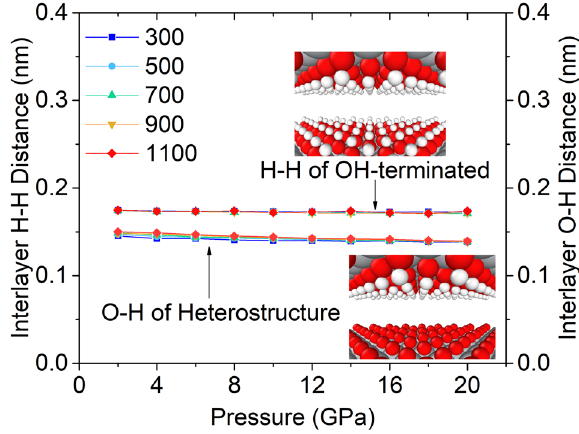
Fig. 5 Interlayer H – H and O – H distances. Interlayer termination – termination distance for the OH-terminated (H – H distance) and heterostructure (O – H distance) MXenes as a function of pressure at 300, 500, 700, 900, and 1100 K averaged over the duration of sliding. The insets are zoomed-in views of the corresponding MXene models prior to thermalizing and